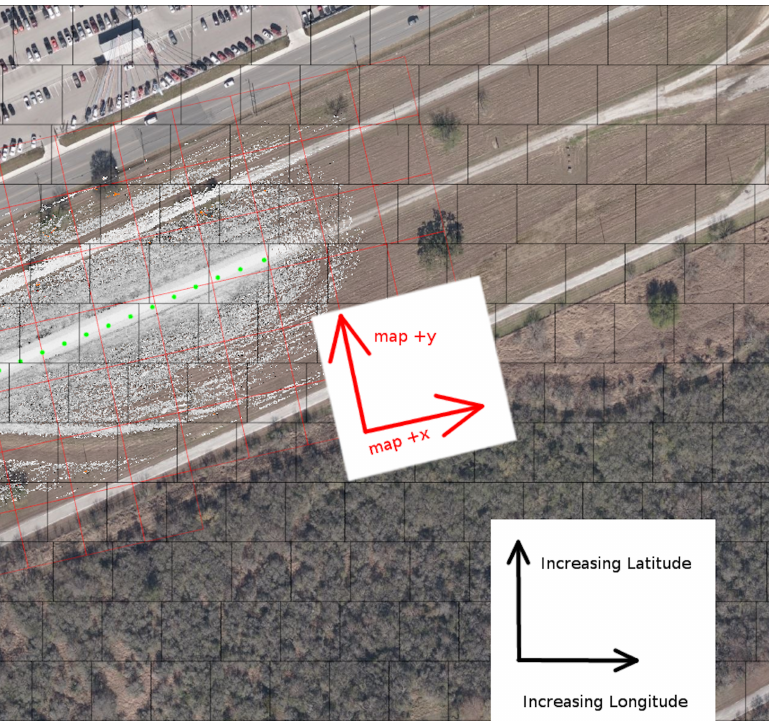
Figure 1. A visualization in mapviz [41] of the costmap layer (the greyscale dots) of a persistent map of a portion of the SwRI test track. Source Tiles are outlined in red, and are aligned to the map space (appearing at an angle in this image). GPS fixes are shown in green. WGS84 Tiles are outlined in black, aligned with longitude/latitude space. All tiles are 128 × 128 quadrangles, at a scale of about 25 m on a side under this vehicle’s sensor configuration. The satellite imagery is shown only for